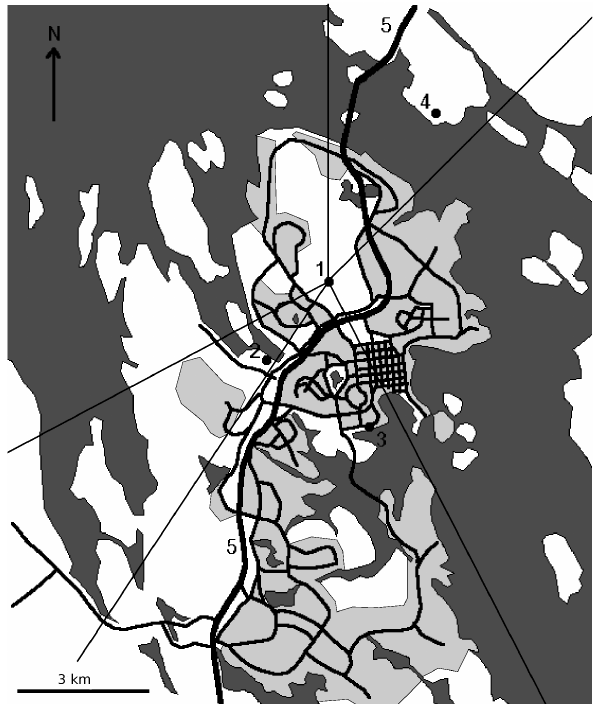
Fig. 1. Map of Kuopio showing Puijo (1) and its surroundings. The dark grey areas are lakes, the light grey areas residential areas, and the white areas forest. Also shown are the location of Savilahti mea- surement station (2), a peat-fired district heating plant (3), a paper mill (4), and a highway (5). The lines emerging from Puijo define sectors for local source analysis. The direction of North and a dis- tance bar of 3km are also shown in the